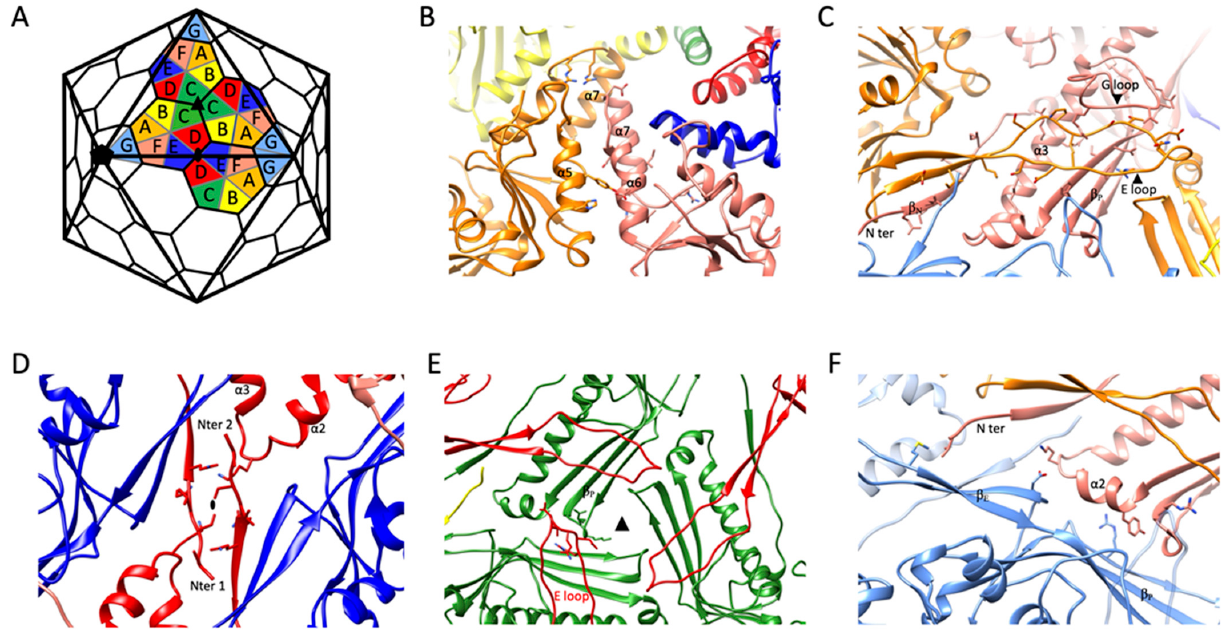
Figure 3. ( A ) Schematic view of the hexamers and pentamers arrangement in a T = 7, d capsid. The seven subunits (named A to G) that constitutes the asymmetric unit are highlighted. ( B – F ) Zoomed views on the five main interacting sites that exist between the MCPs of the ϕ RSA1 capsid. For each panel, the color of the subunits represented is related to the color code shown in the schematic in ( A ). The side chains of the residues forming putative hydrogen bonds are also shown. ( B ) Interactions between two A domains of two MCPs (subunits A (orange) and F (salmon)) of the same capsomer. ( C ) Interactions between the P- and N- domains of a given subunit (subunit F—salmon) and the E-loop of a neighbor subunit of the same capsomer (subunit A—orange). ( D ) Interaction occurring at the 2-fold axis between two N-termini from two MCPs of two different capsomers (subunits D—red). ( E ) Interaction occurring at the 3-fold axis between the E-loop of a given subunit (subunit D—red) and the P-domain of a MCP of a neighbor capsomer (subunit C—green). ( F ) Interaction taking place between the P-domain of a subunit (subunit F—salmon) with the P- and N- domains of a MCP from a different capsomer (subunit G—light blue).